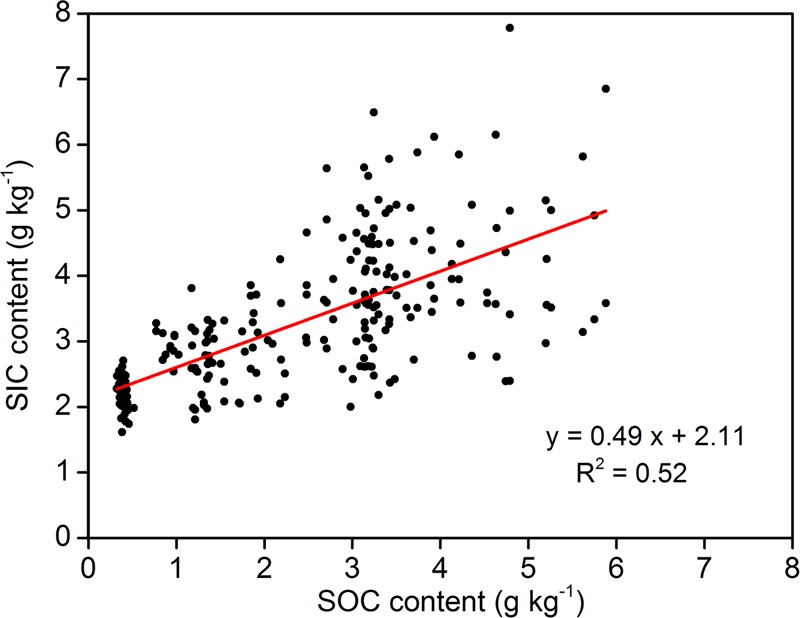
Relationship between soil organic carbon (SOC) and inorganic carbon (SIC) contents (using all 260 samples within 0–100 cm depth from four sample plots). Significance of the linear regression was considered as P < 0.01.